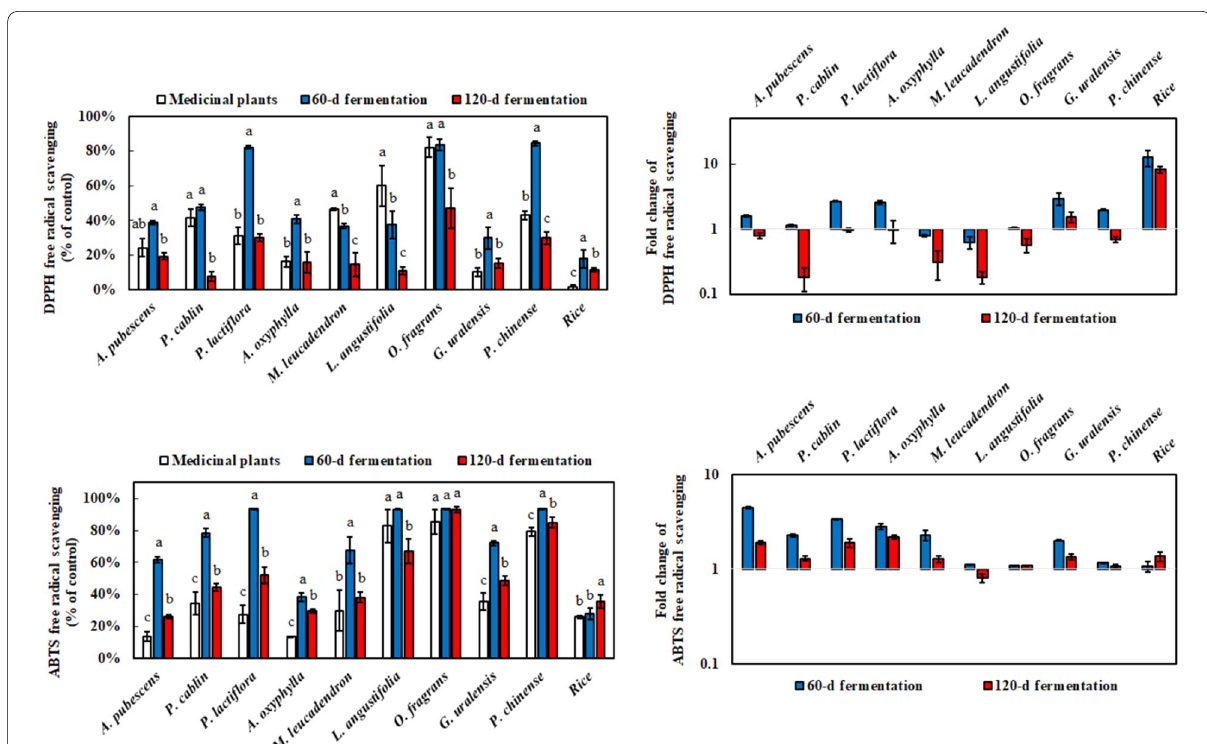
Fig. 2 Antioxidant capacity determined using DPPH and ABTS scavenging methods with or without the fermentation of medicinal plants at 0.5 and 0.0625 mg/mL by M. ruber BCRC 31,535. The ratio of 60 and 120 days of fermentation to medical plants was depicted on the right side of the figure. Results are mean S.D. (n ± =